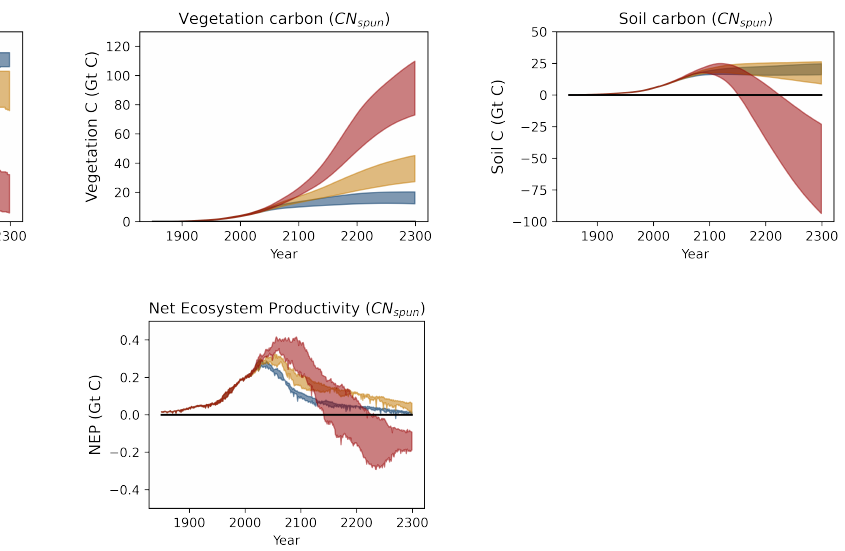
Figure 7. Output from the transient-ens simulations for the three RCP scenarios and CN spun . The changes in permafrost extent, vegetation carbon, soil carbon and net ecosystem productivity (NEP) are